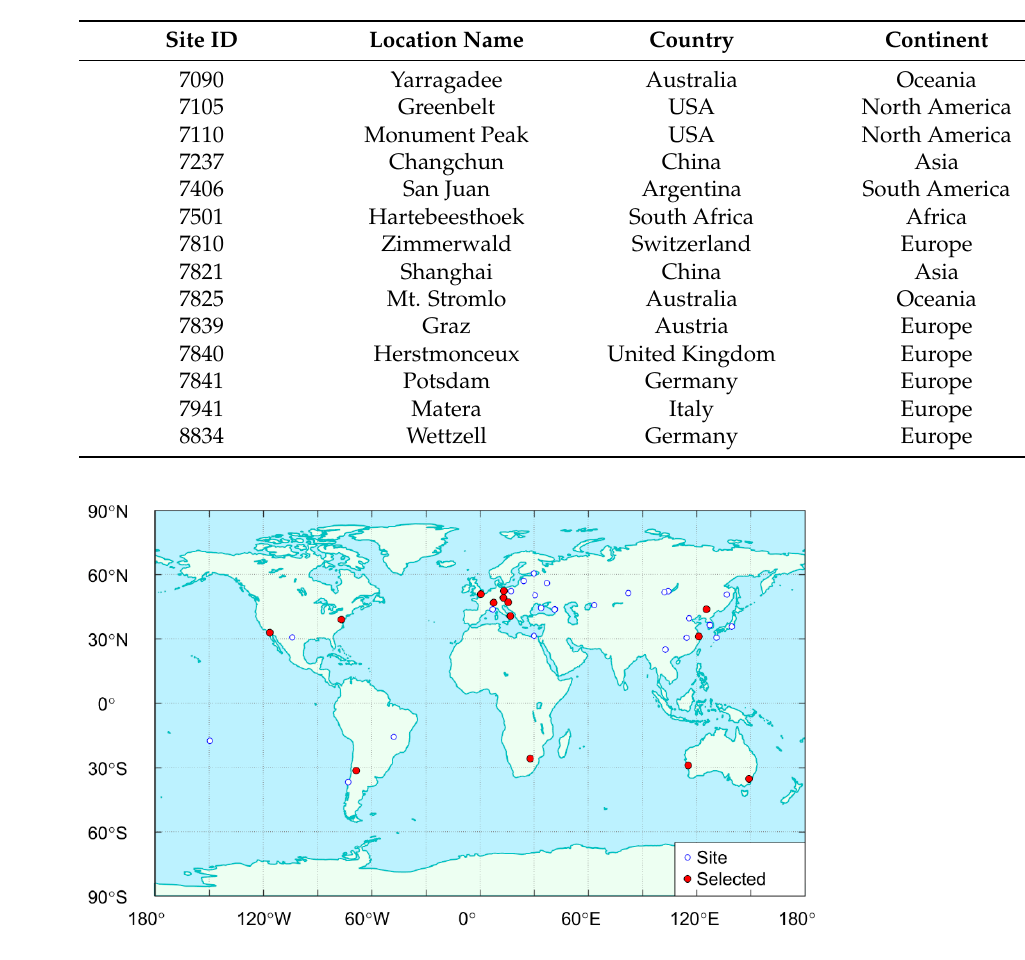
Figure 3. Geographical distribution of SLR tracking sites for Galileo satellites.